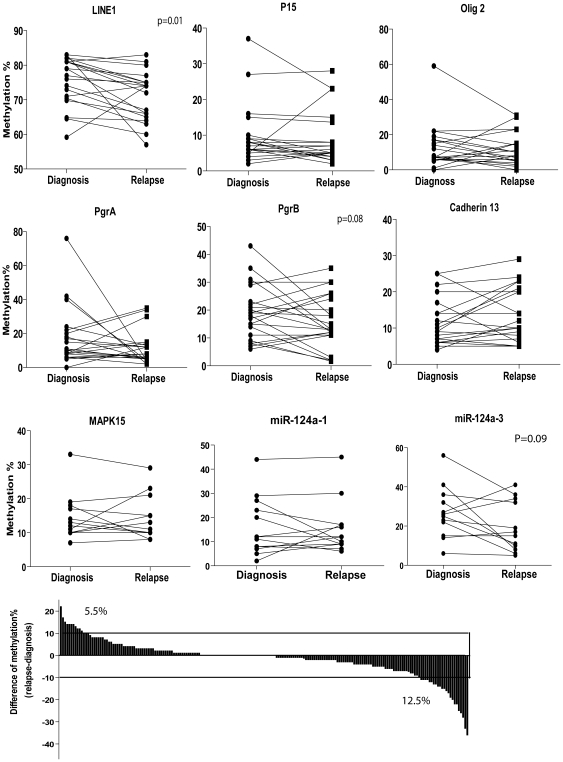
Measurement of gene methylation in MDS patients with secondary resistance.A. Pyrosequencing of gene methylation. We measured methylation of LINE1 and five genes in 20 MDS patients between diagnosis and relapse. Paired t test was used to measure the difference in methylation levels. B. Difference of methylation between diagnosis and relapse. We calculated the difference in methylation between diagnosis and relapse and highlight changes above a 10% cut-off.